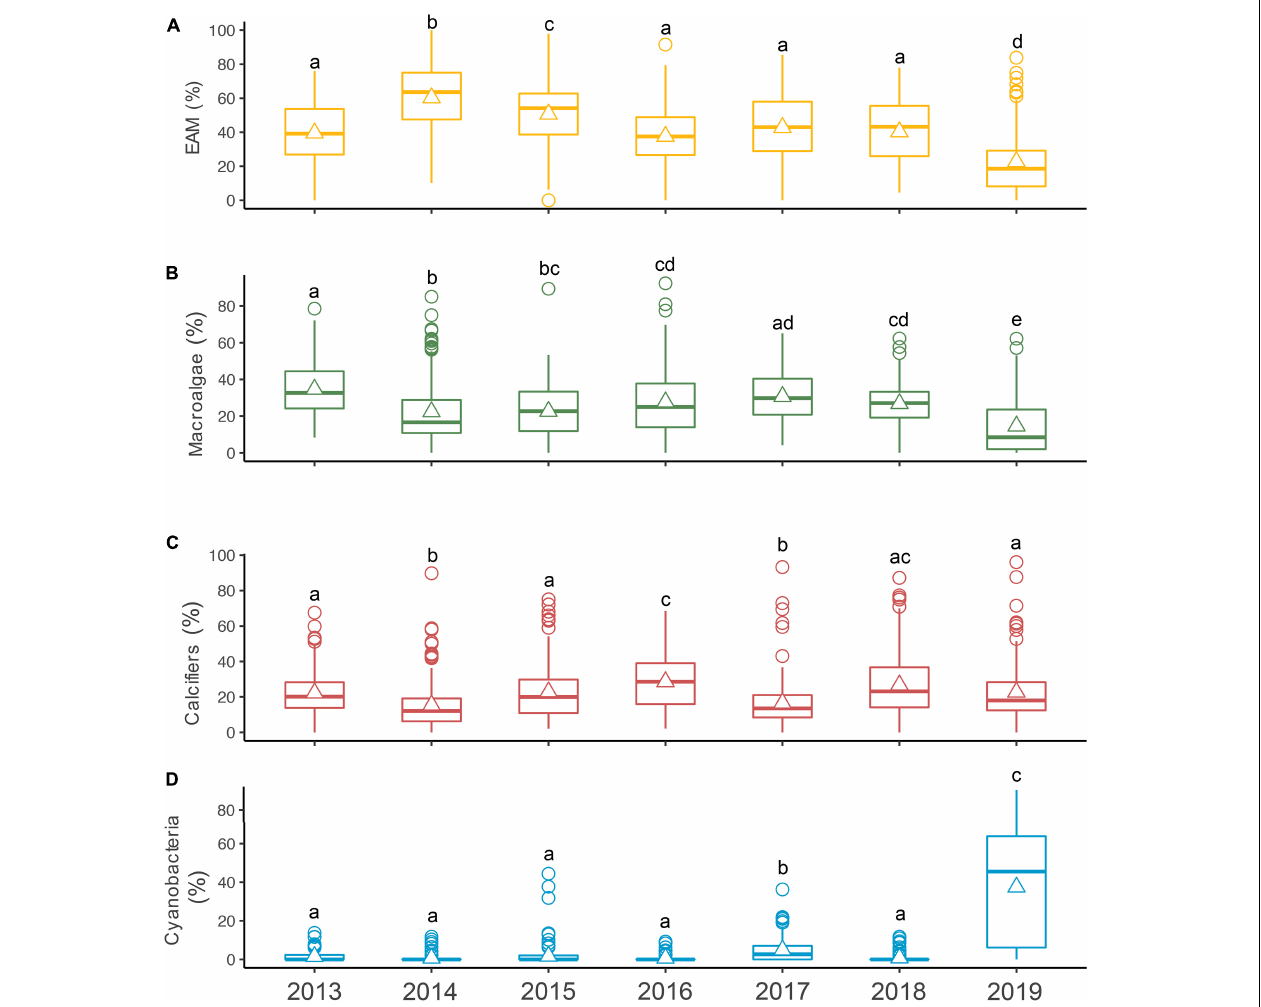
FIGURE 4 | Benthic groups temporal dynamics. Boxplots illustrating temporal dynamics of (A) epilithic algal matrix (EAM; yellow), (B) macroalgae (green), (C) calcifiers (red) and (D) cyanobacteria (blue) during the 7-year monitoring in Fernando de Noronha Archipelago. Horizontal lines indicate median values, triangles indicate mean values and circles indicate outliers. Years within groups sharing the same letter are not significantly different (Kruskal-Wallis test with Tukey post hoc – p <